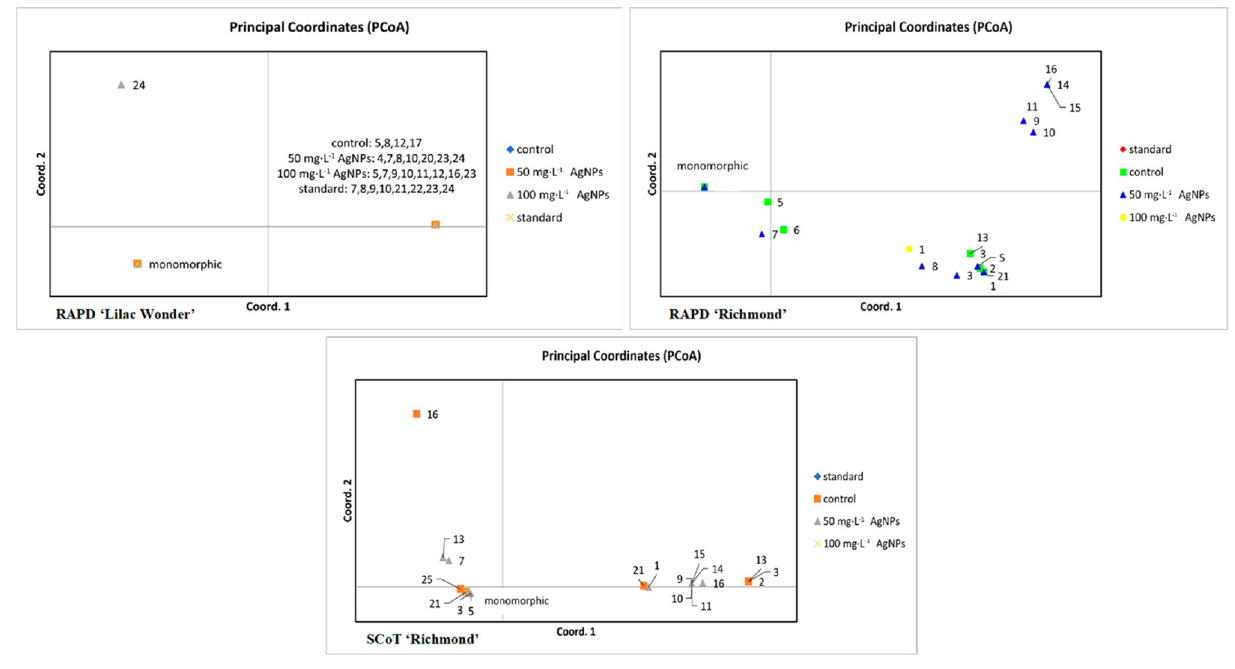
Figure 8. Graphs of principal coordinates analysis (PCoA) of Chrysanthemum × grandiflorum ‘Lilac Wonder’ and ‘Richmond’ plants obtained after 0 (control), 50, and 100 mg·L − 1 AgNPs treatment and in standard plants, based on randomly amplified polymorphic DNA (RAPD) and start codon targeted polymorphism (SCoT) analyses. Plants representing the same band pattern as the predominant standard are collected within a single group named ‘monomorphic’.